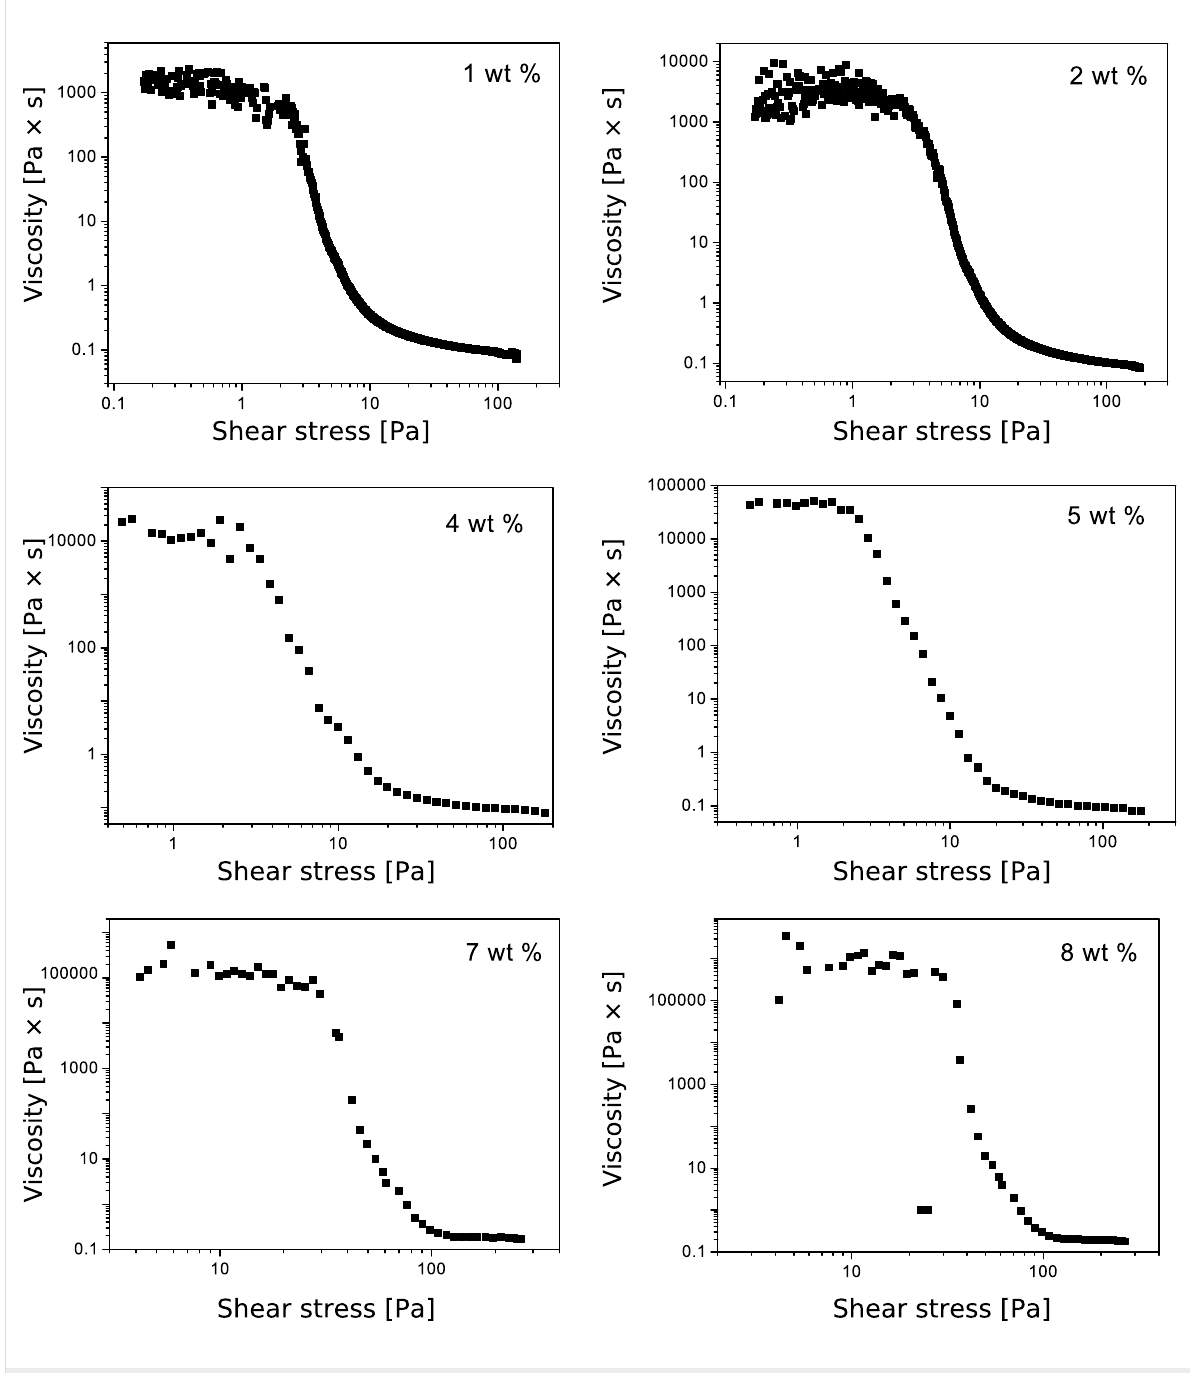
Figure 1: Flow curves of ODA-C /silicone oil gels at 25 °C and increasing stress.